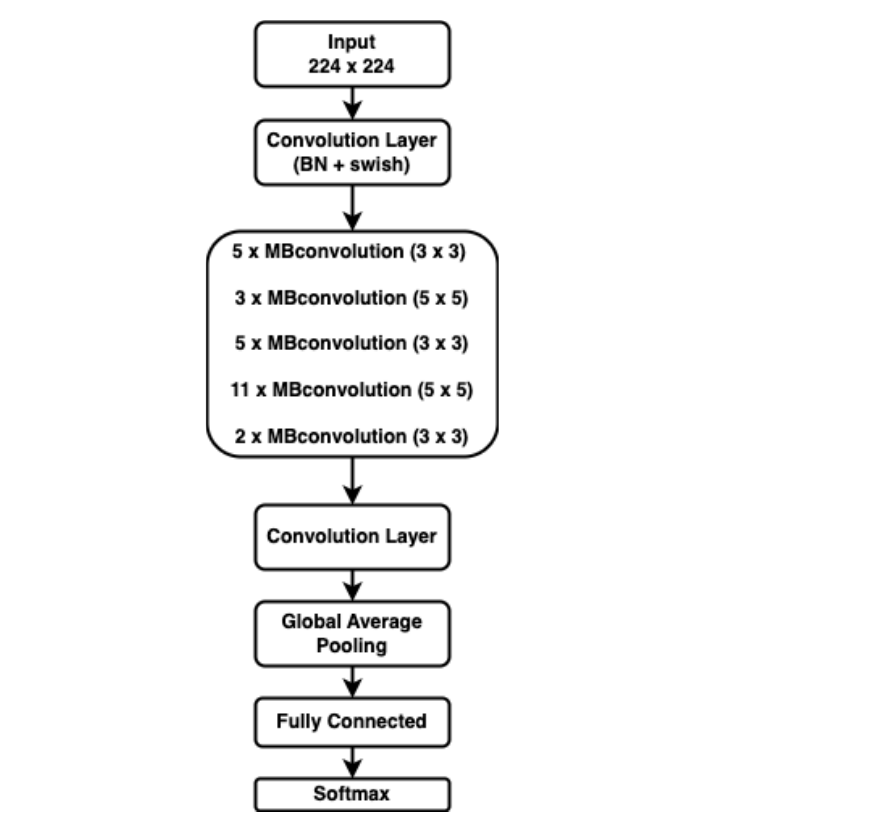
Figure 1. Basic architecture of EfficientNetB3.